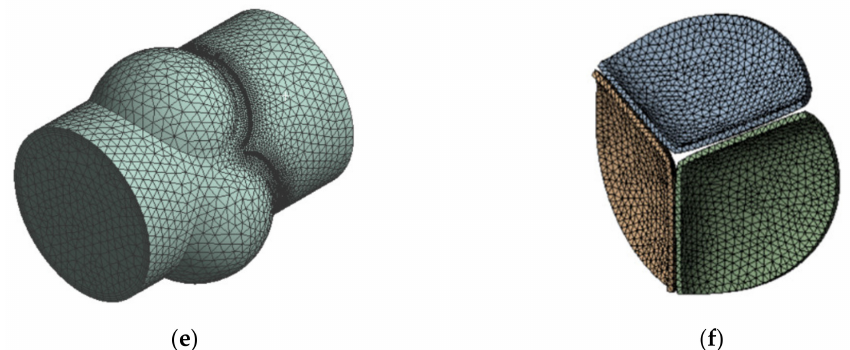
Figure 1. ( a ) 3D aortic valve model. The grey surface is the cross-sectional plane in the longitudinal direction. The arrows show the direction of flow at the inlet and outlet. ( b ) 2D view of the cross-sectional plane. Only the top half of the model is shown due to the symmetry. The dashed line represents the symmetry line. ( c ) Boundary conditions shown on the cross-sectional plane. ( d ) Transient inlet velocity profile of the blood flow. ( e ) Mesh of the fluid domain. ( f ) Mesh of the solid